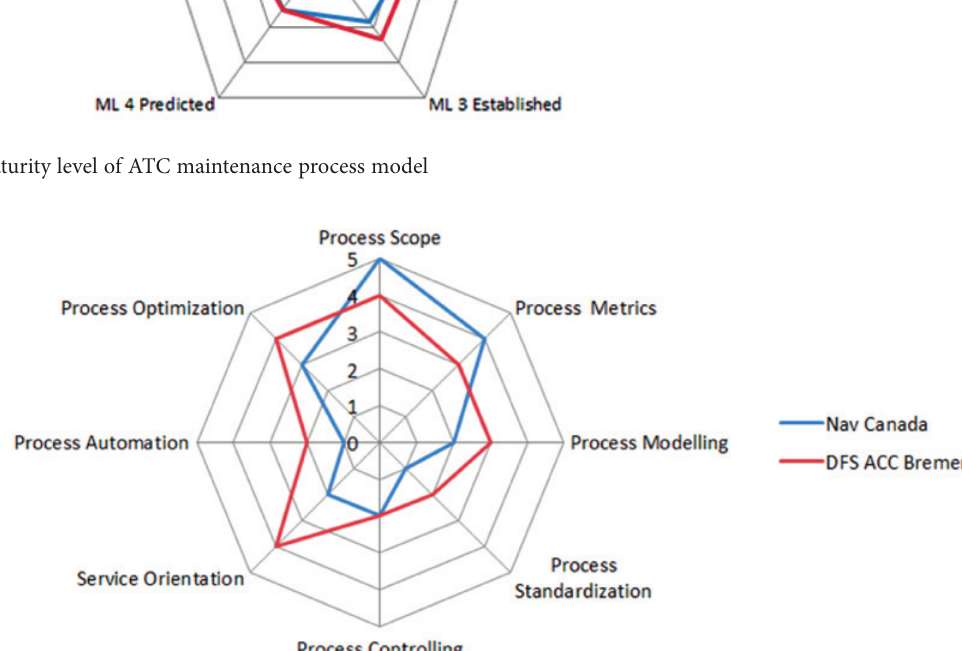
Fig. 6. Process attribute